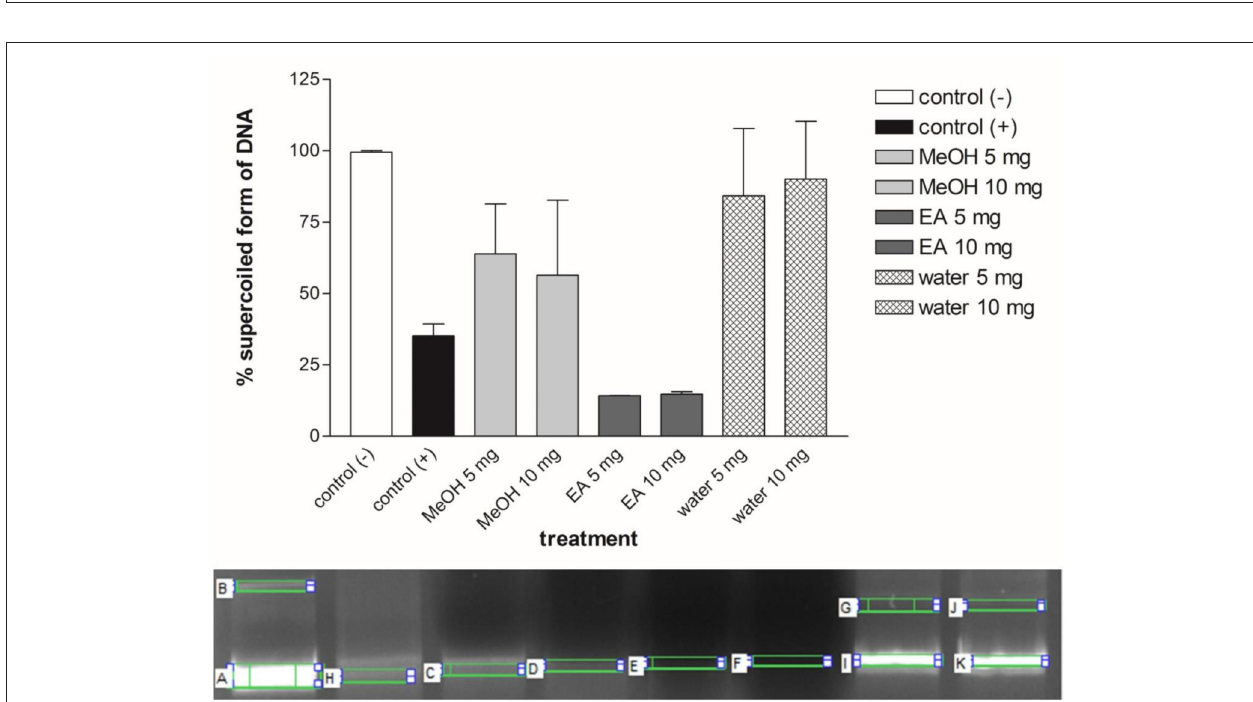
FIGURE 5 | percentage of DNA protection analysis and gel view of plasmid DNA protection test for each Ononis natrix extracts. A,B: ( + ) control, H: ( − ) control, C: 5mg methanol extract, D: 10mg methanol extract, E: 5mg ethyl acetate extract, F: 10mg ethyl acetate extract, I-G: 5mg water extract, K-J: 10mg water extract. Striped bars indicate significantly different